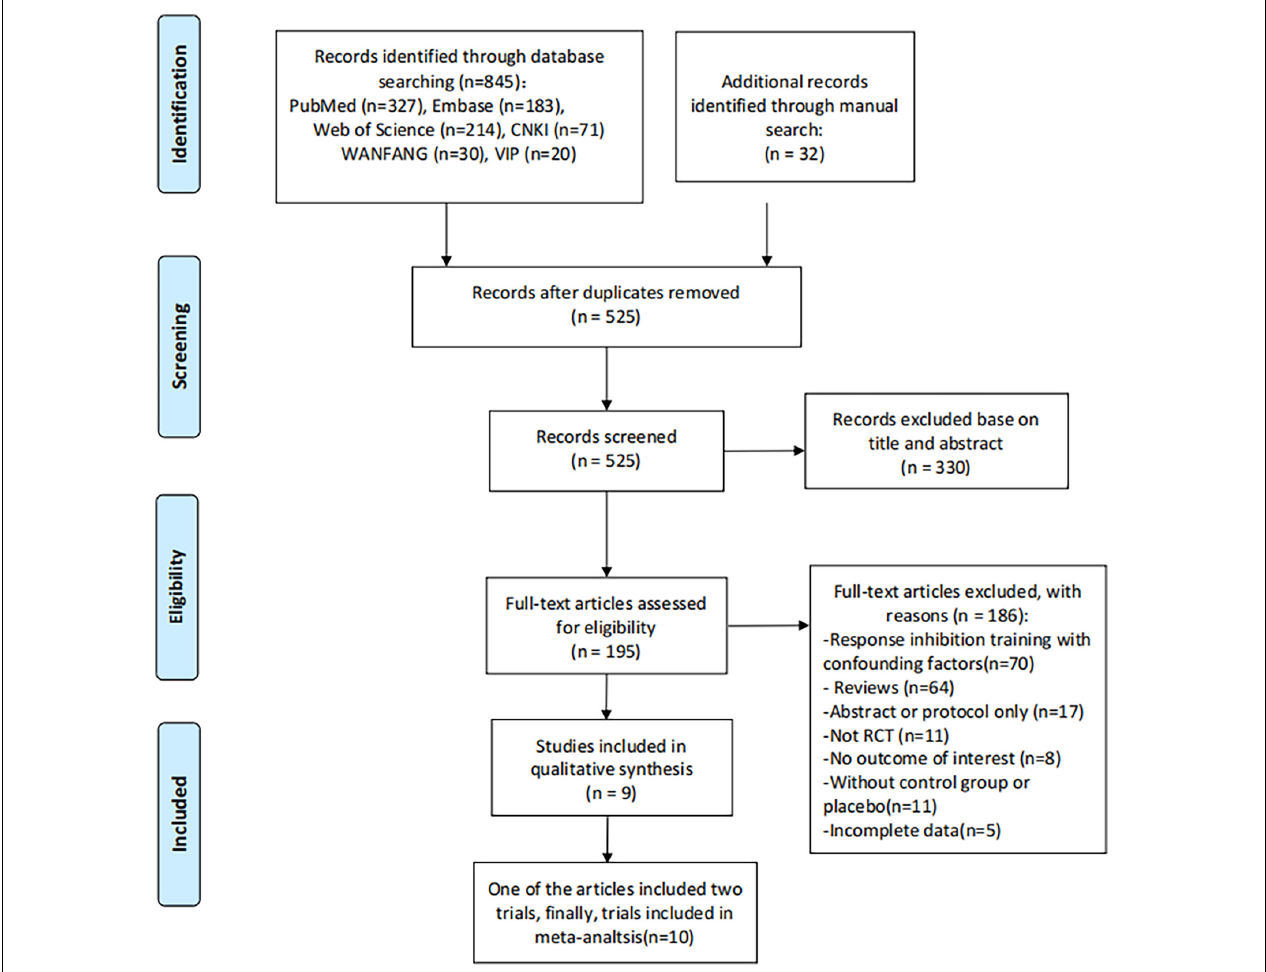
FIGURE 1 | Flow diagram of study searching and selection